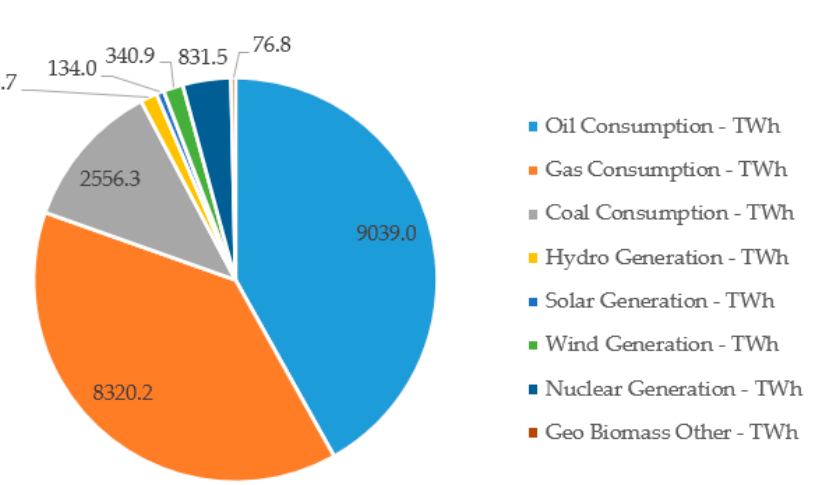
Figure 7. The energy consumption resource distribution in the U.S.A. in 2020 (according to the data source [14]).